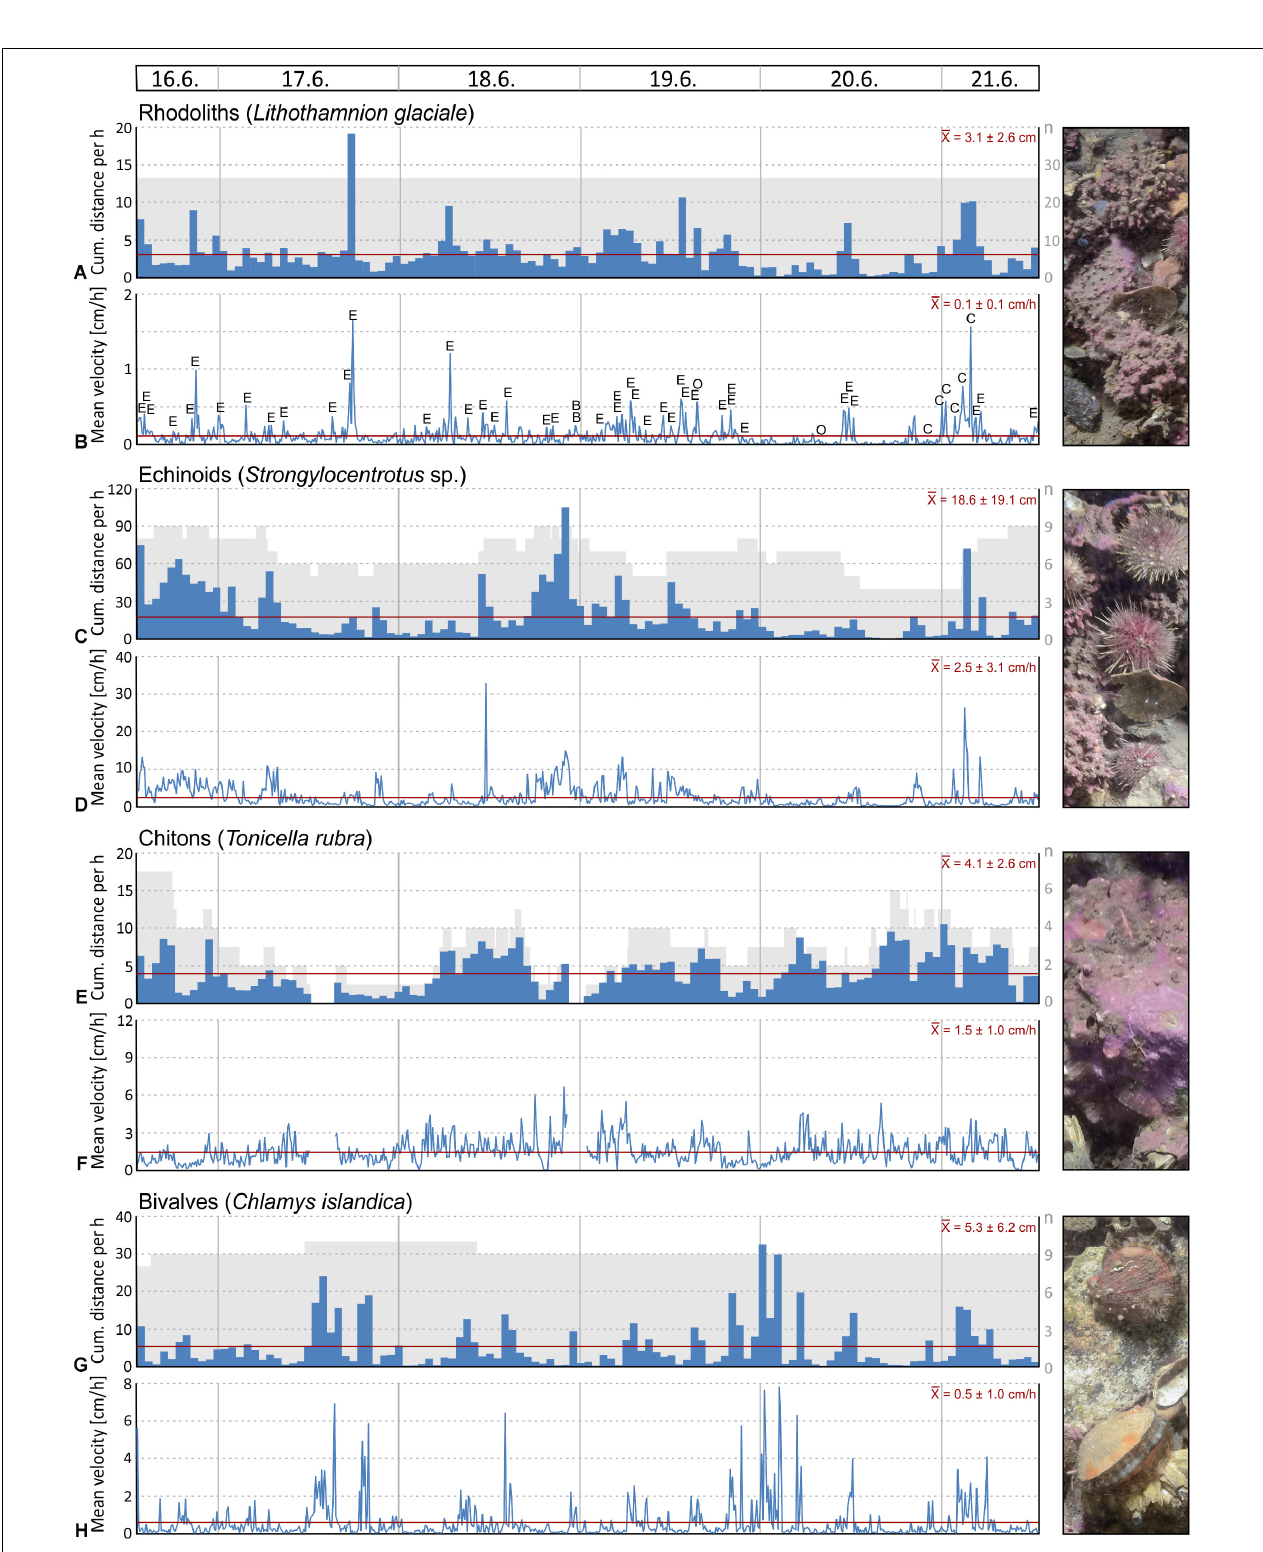
FIGURE 15 | Cumulative distance per hour, mean velocity, and number of selected macrobenthos organisms, as tracked on images of the lander’s camera system during the 6 days of deployment in Mosselbukta: rhodoliths (A,B) , echinoids (C,D) , chitons (E,F) , and epibenthic bivalves (G,H) . Abbreviations used for indicating disturbances: E, echinoid; O, ophiuroid; C, crab; B, bivalve.